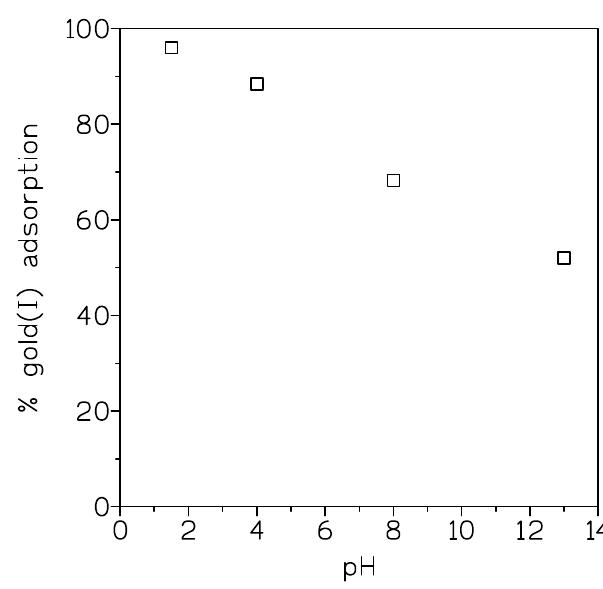
Figure 1. Effect of the pH variation on gold(I) adsorption. Time: 2 h.